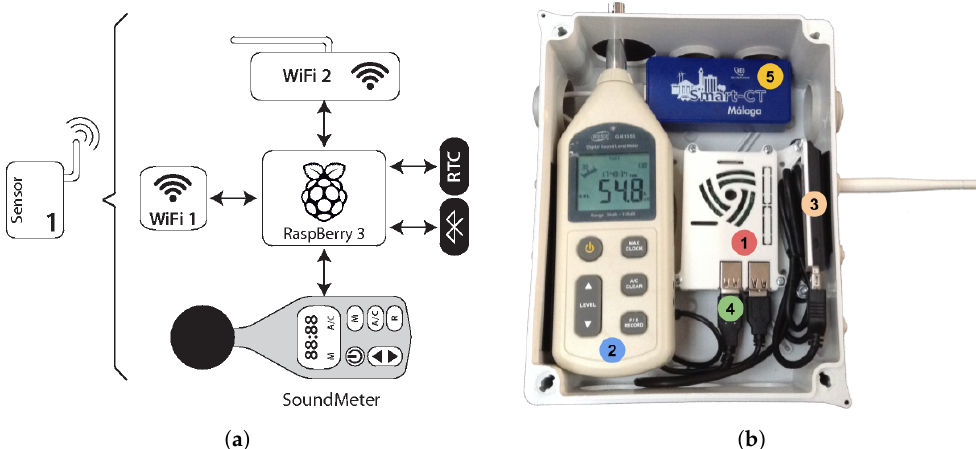
Figure 2. Different elements and views of the road sensor system: ( a ) Sensor block diagram; ( b ) Actual photo of the sensor.